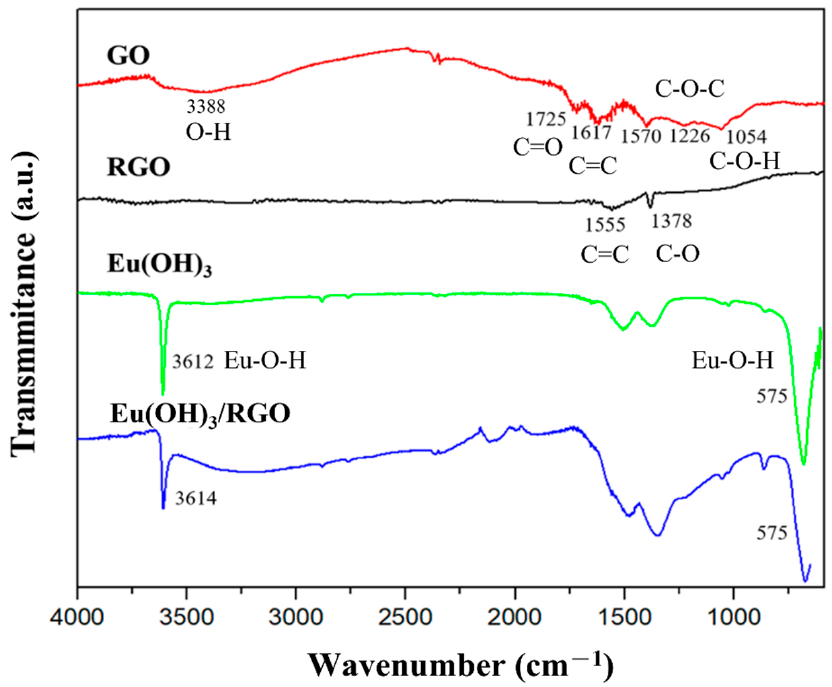
Figure 4. Fourier transform-infrared (FT-IR) spectra of GO, RGO, and Eu(OH) 3 nanorods and Eu(OH) 3 /RGO 220 nanocomposites.